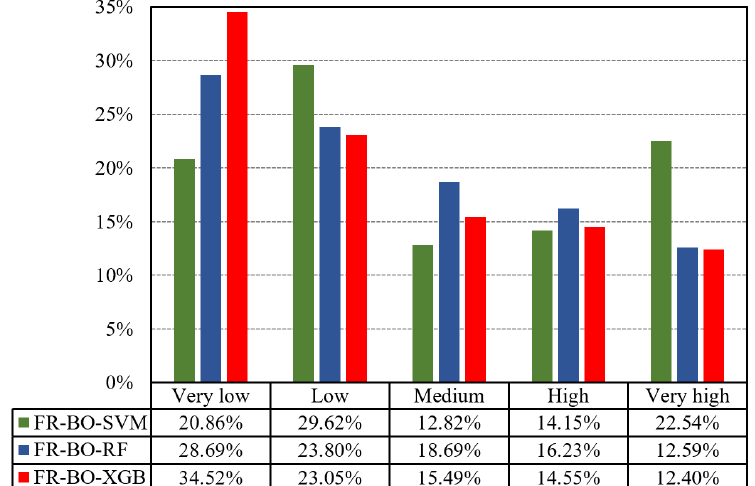
Figure 4. Percentage of the risk level of three machine learning algorithms.